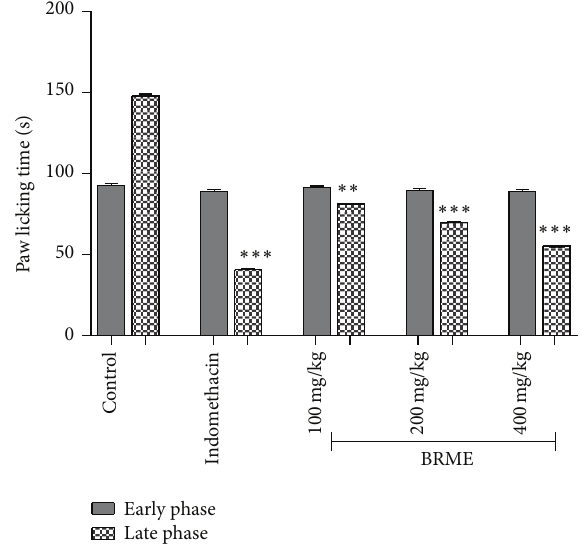
Figure 3: Effect of BRME and indomethacin on the licking induced by a formalin injection in rats. The total time spent licking the hind paw was measured in the early and late phases after intraplantar injection of formalin. Results are represented as mean ± SEM ( 𝑛 = 6 ). ∗∗ 𝑃 < 0.01 , ∗∗∗ 𝑃 < 0.001 , when compared to the